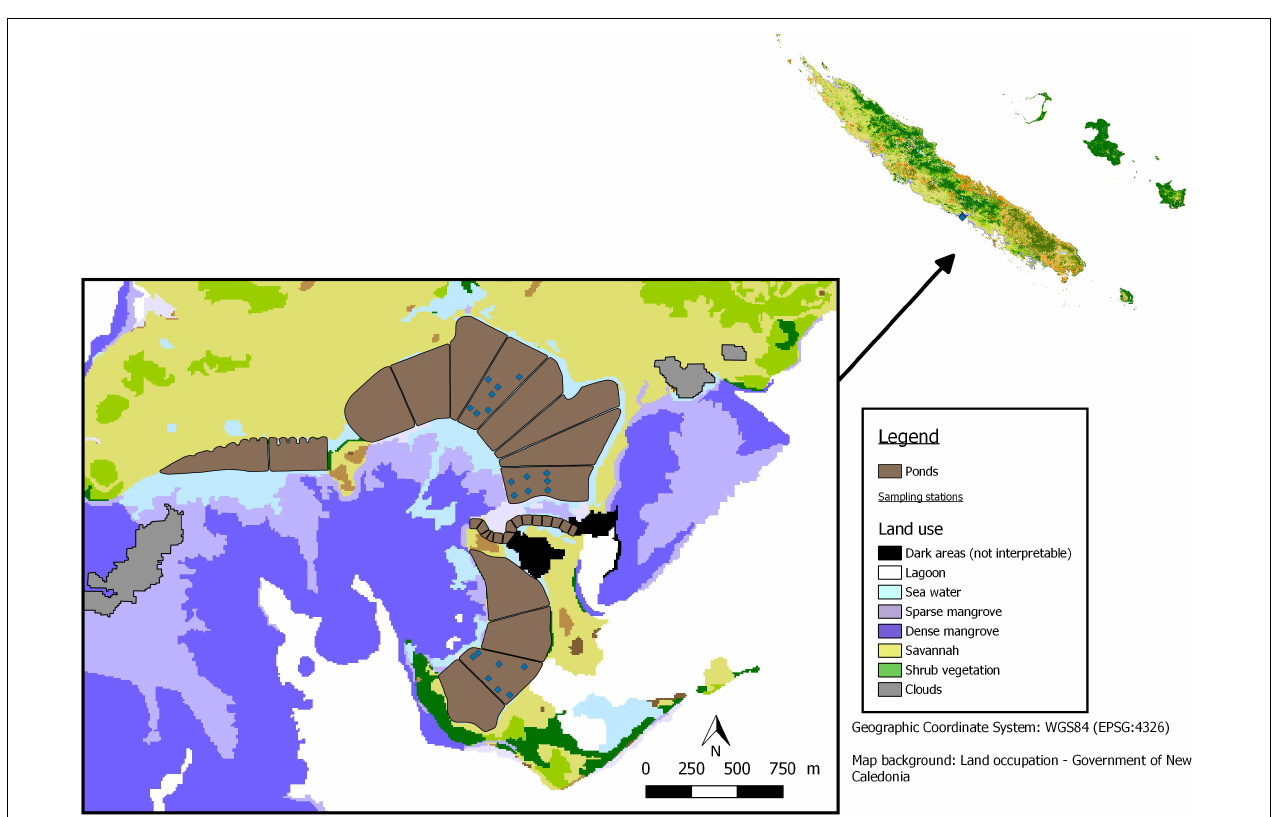
FIGURE 1 | Map showing the location of sampling stations in the three ponds built in 1983 behind the mangrove of Teremba Bay (New